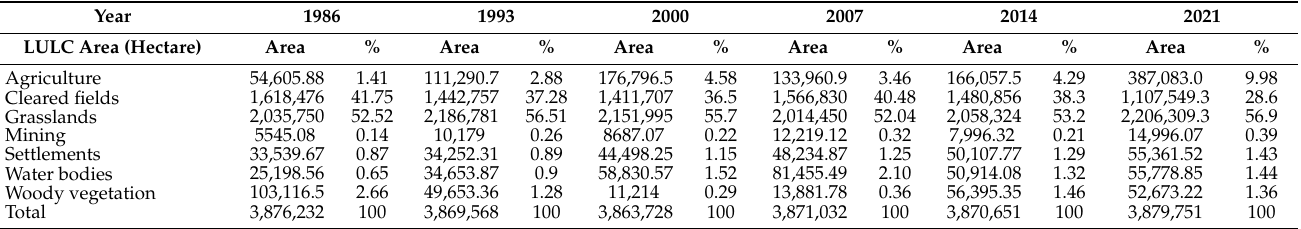
Figure 3. LULC patterns in the Vaal Dam Catchment from 1986 to 2021 in 7-year intervals. The LULC classifications based on six different images were obtained based on the best combination of mtry and ntree parameters in RF. Table 4 above shows the selected combinations of the two input parameters used to train the classifier for each year according to their best performance. Table 5 summarises the class areas in hectares LULC patterns for 1986, 1993, 2000, 2007, 2014 and 2021. Table 5. The LULC class areas in hectares and their relative proportions, based on the total